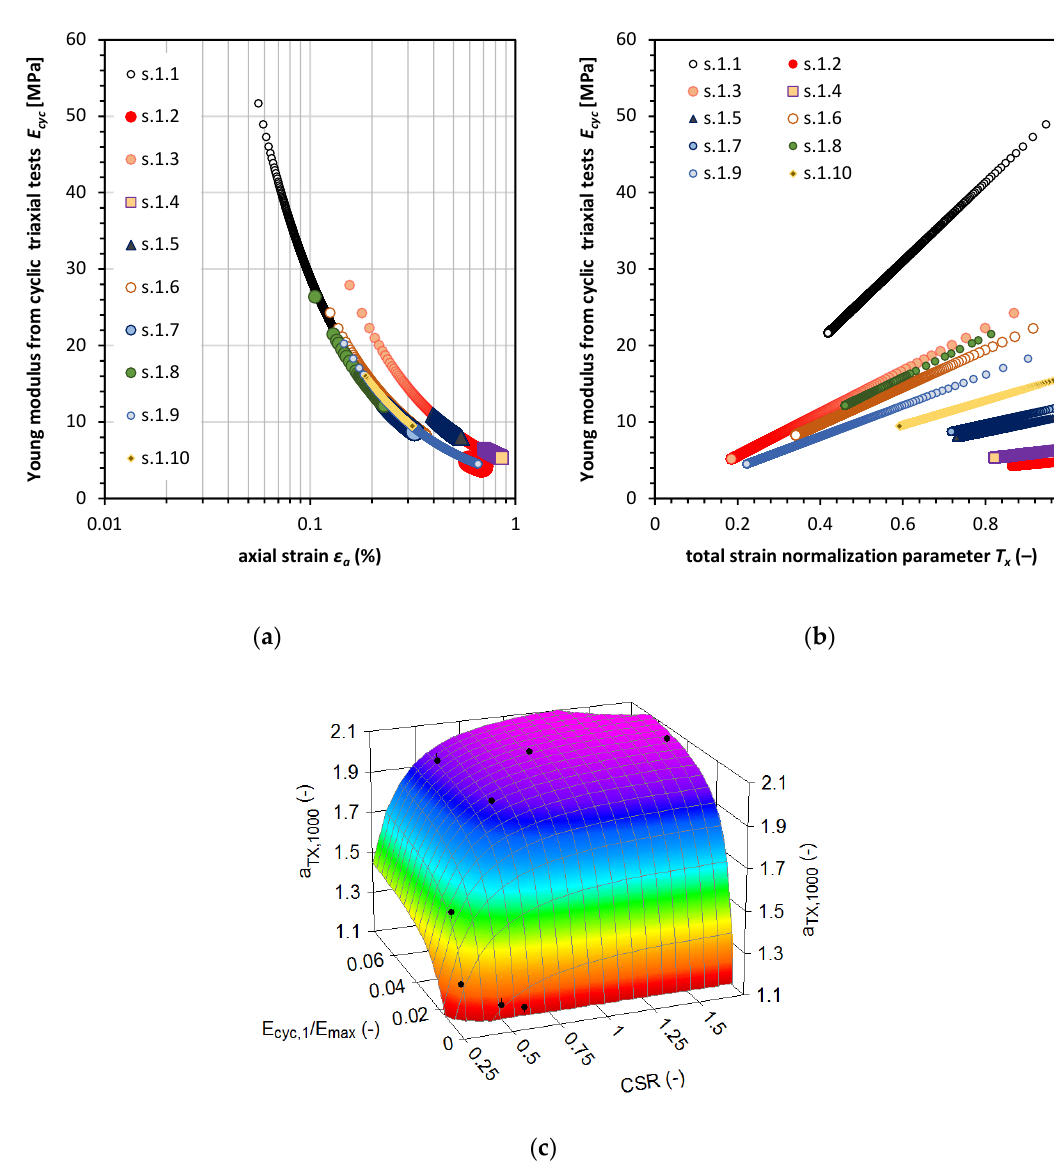
Figure 11. Total degradation of Young modulus in cyclic loading E cyc versus axial strain ( a ), and versus total strain normalization parameter T x ( b ), the relation between the a TX parameter and the normalized cyclic Young modulus E cyc / E max. ( c ) the impact of the normalized Young modulus and cyclic stress ratio (CSR) on the a TX , 1000 parameter value .